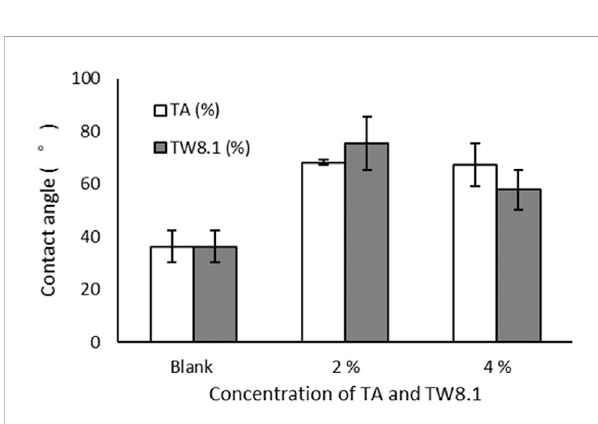
FIGURE 11 Water contact angles of handsheets treated with tannic acid (TA; blank control, 2% and 4%) and tannin-rich bark extract (TW; blank control, 2% and 4%). The measurements of 60 g/m 2 and 130 g/m 2 papers were pooled together (mean ±